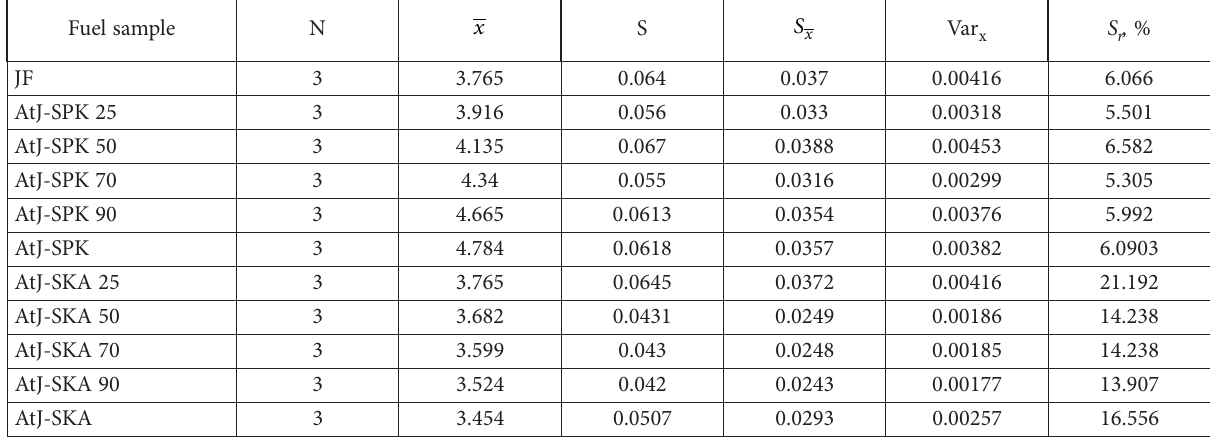
Table A2. Statistical error analysis of kinematic viscosity measurements (source: author development) Fuel